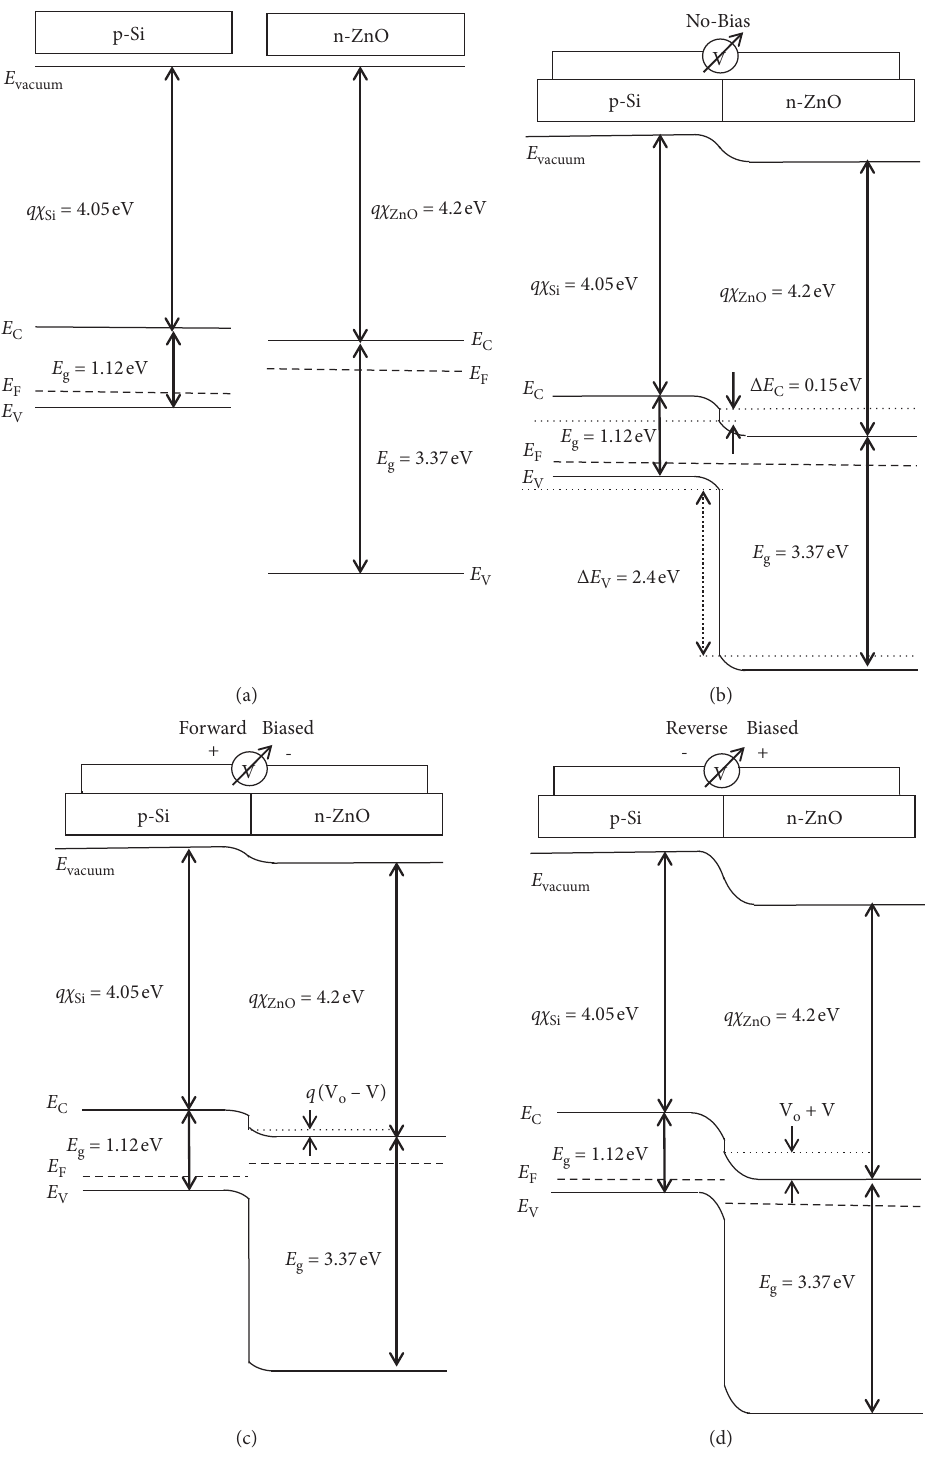
Figure 8: Energy band diagram: (a) isolated regions before forming the junction; (b) unbiased junction; (c) forward biased junction; (d) reverse biased